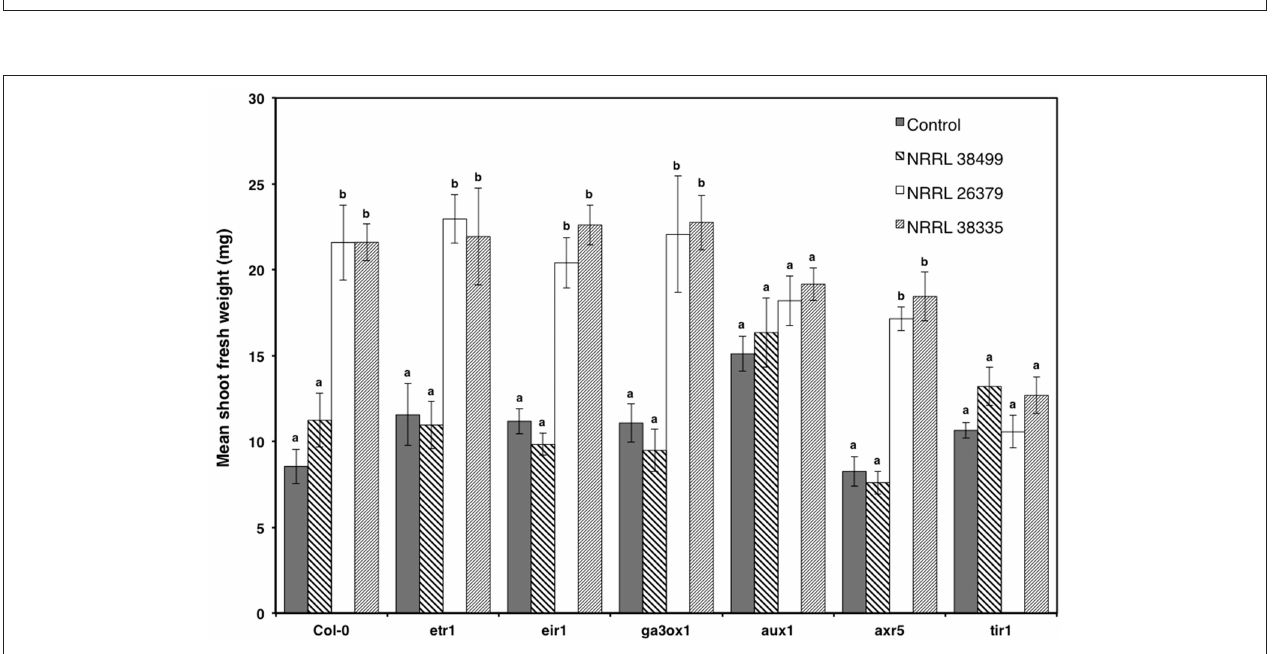
FIGURE 7 | Growth response of A. thaliana hormone signaling mutants to F. oxysporum volatiles. Growth response of six mutants to volatiles produced by NRRL 38499, NRRL 26379, and NRRL 38335 are shown. Means and standard errors for two biological replicates per treatment, with five seedlings per replicate, are shown. Different letters on columns represent statistically significant differences within each mutant line by one-way analysis of variance.